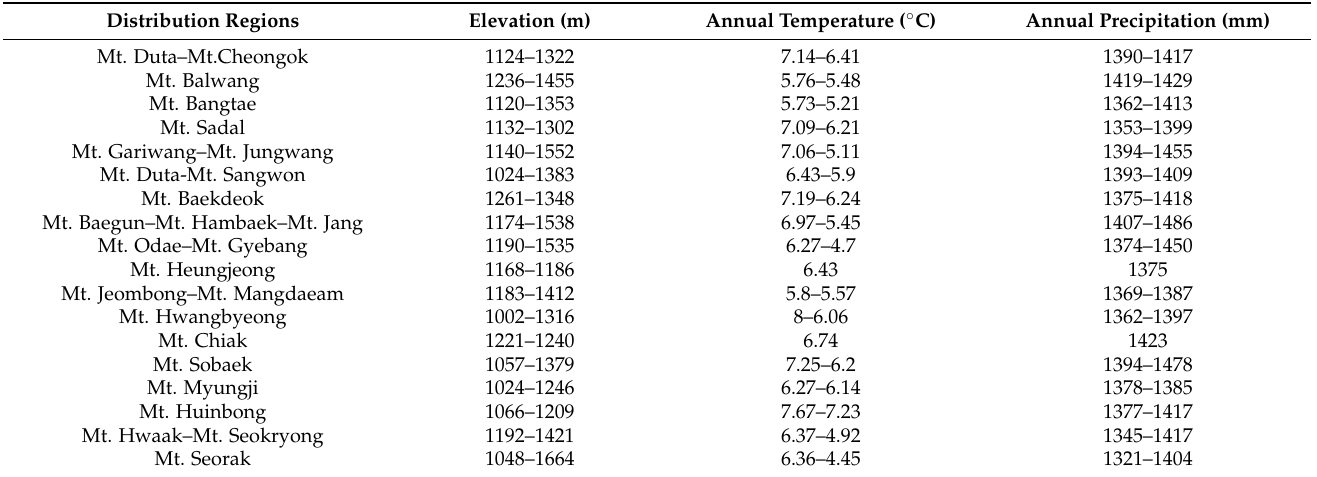
Table 1. The topographical environmental characteristics of Abies nephrolepis using field survey plot and actual vegetation map. (The average temperature and average precipitation value were based on Worldclim data (30 arcsec)).